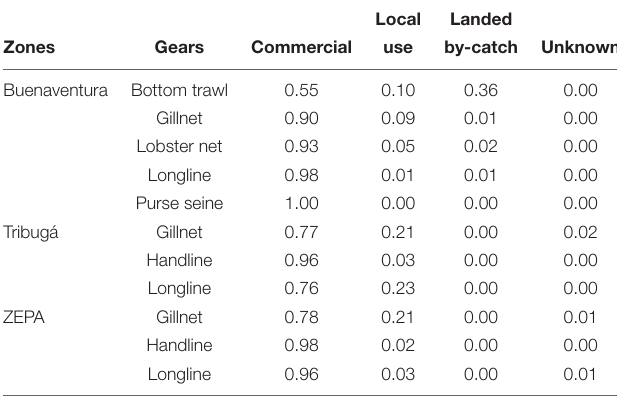
TABLE 6 | Proportions of categories related to fishers’ use of the species registered in the catch of SSF in the Colombian Pacific.